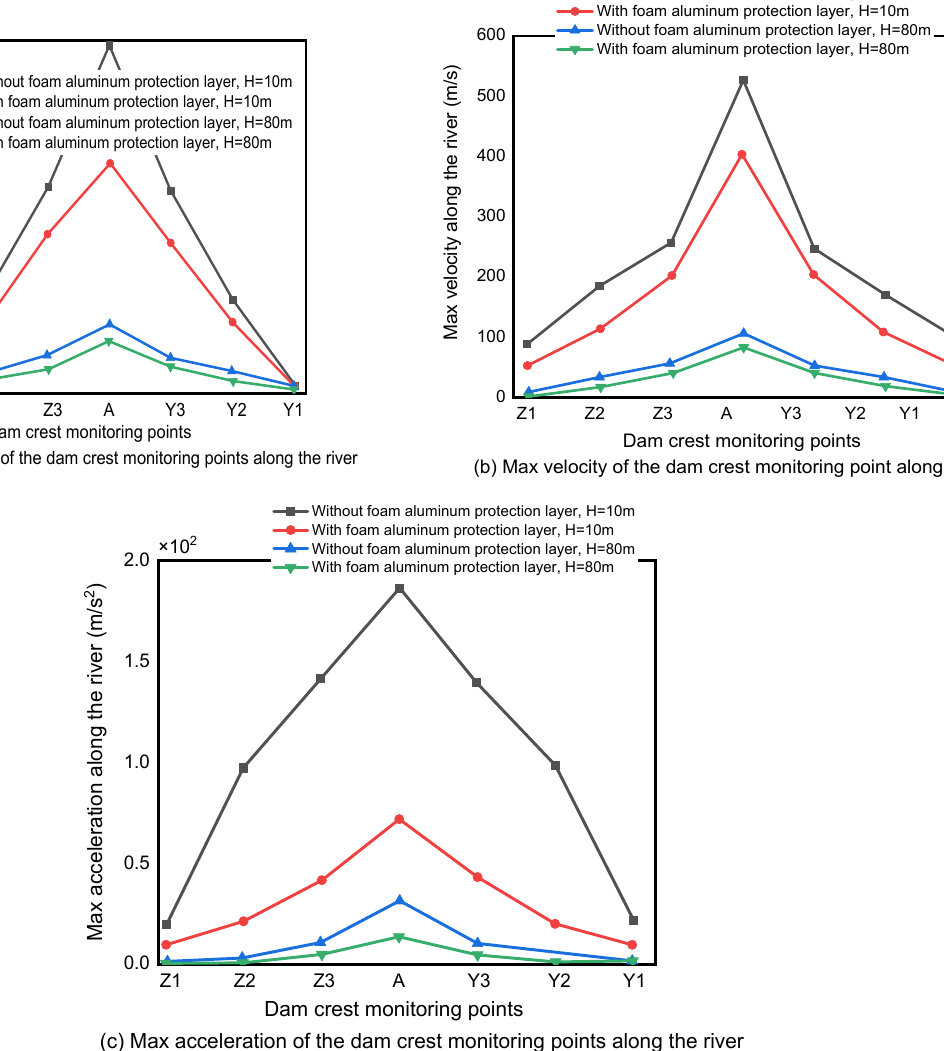
Figure 29. Dynamic response of dam crest monitoring point with and without a foamed aluminum protective layer.